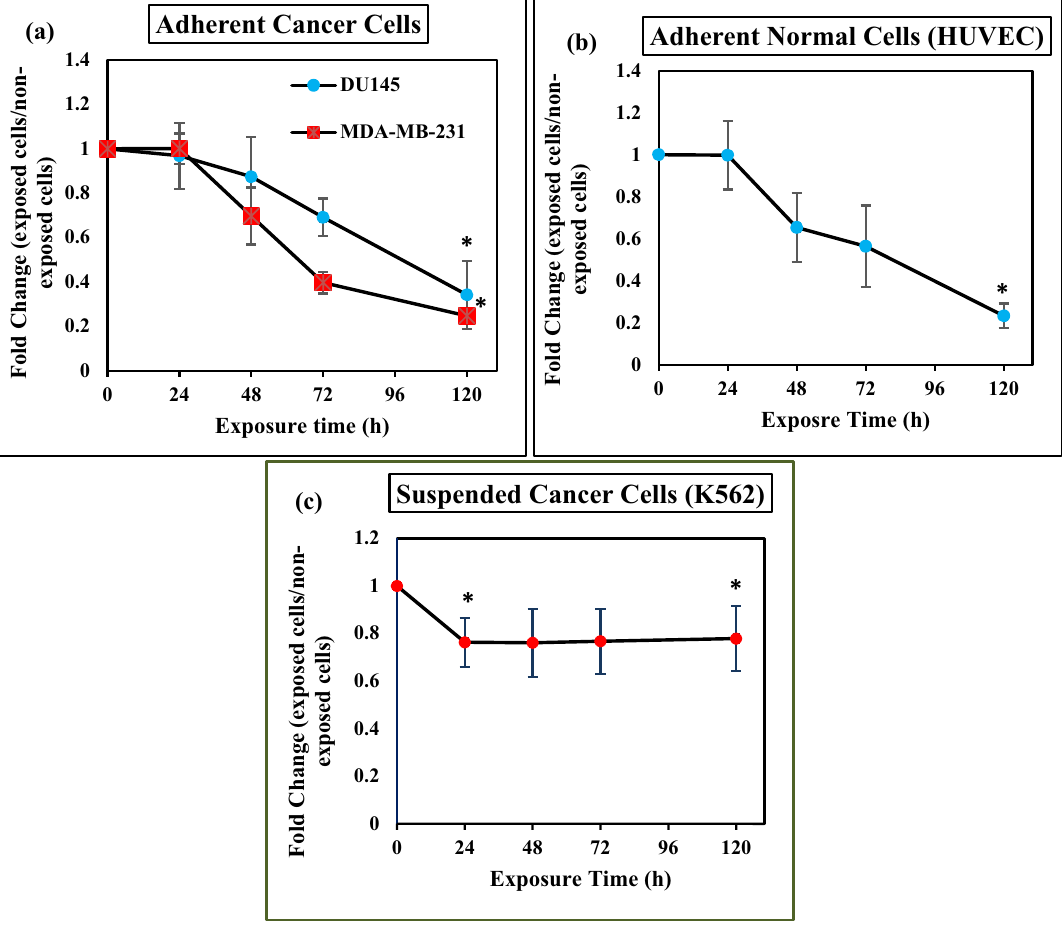
Figure 7. Extremely Low frequency electromagnetic fields decrease cell numbers. Plot showing results of fold change (decrease) following exposure ELF-EMF at long time intensity 100 mT in ( a ) cancerous cells (DU145 (0.01 Hz), MDA-MB-231 (1 Hz)), ( b ) non-cancerous cells (HUVEC) frequency 0.01 Hz in a time-dependent manner. ( c ) plot showing fold change of suspended cells (K562) frequency that was significantly decreased after 24 h exposure and remained constant up 120 h. Decreasing cell number was significant after 120 h exposure in all of the cells. Bars indicate (Means ± SEM) obtained from three or more independent experiments. Statistical significance between non-exposed and exposed groups was evaluated by a t-test. ( P -value < 0.05) was considered to indicate statistical